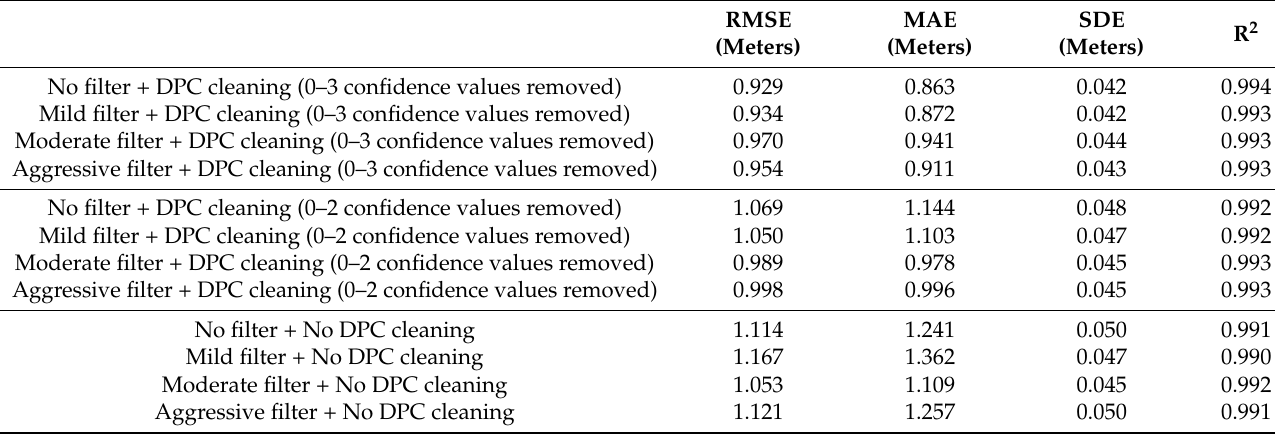
Table 2. Errors and coefficients of determination (R 2 ) for each method used to improve the dense point cloud. Error values were calculated for 512 independent check points used to validate 1963 aerial-photograph-derived digital surface models against the 2014 light detection and ranging digital surface model.